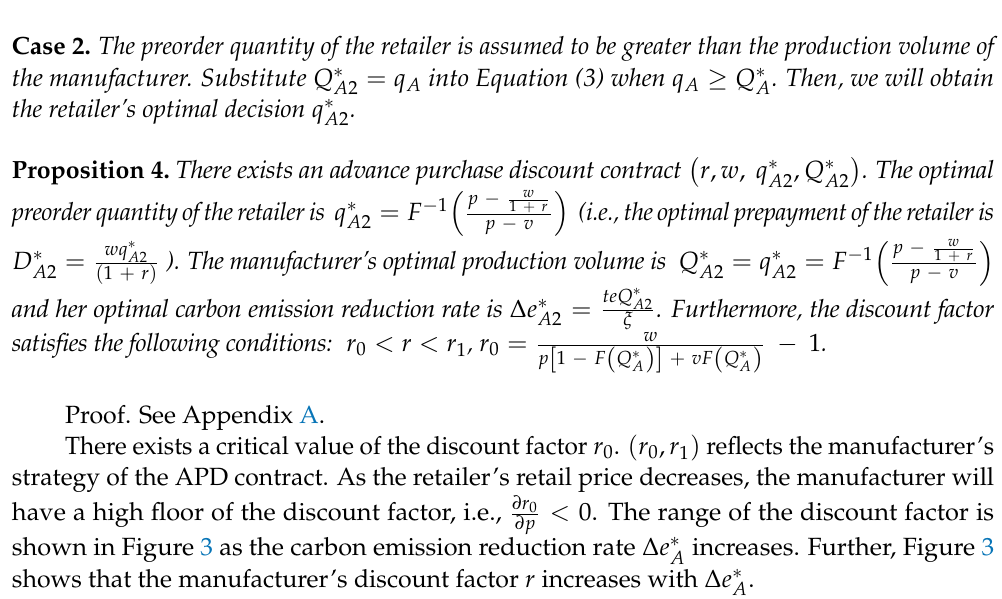
Table 2. Risk-sharing of partners under APD contract Actual Demand Manufacturer Retailer